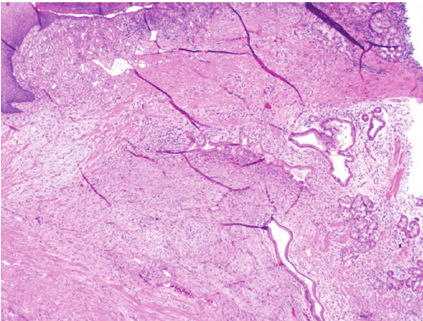
Figure 3: Hematoxylin and eosin stain shows hyperplastic gastric type mucosa with coiled elongated foveolae.